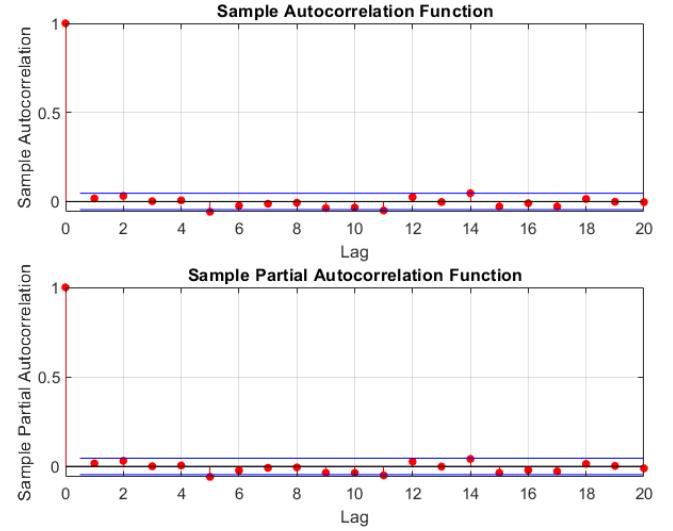
Figure 3. Autocorrelation plot of the DOL/CHF time-series data.